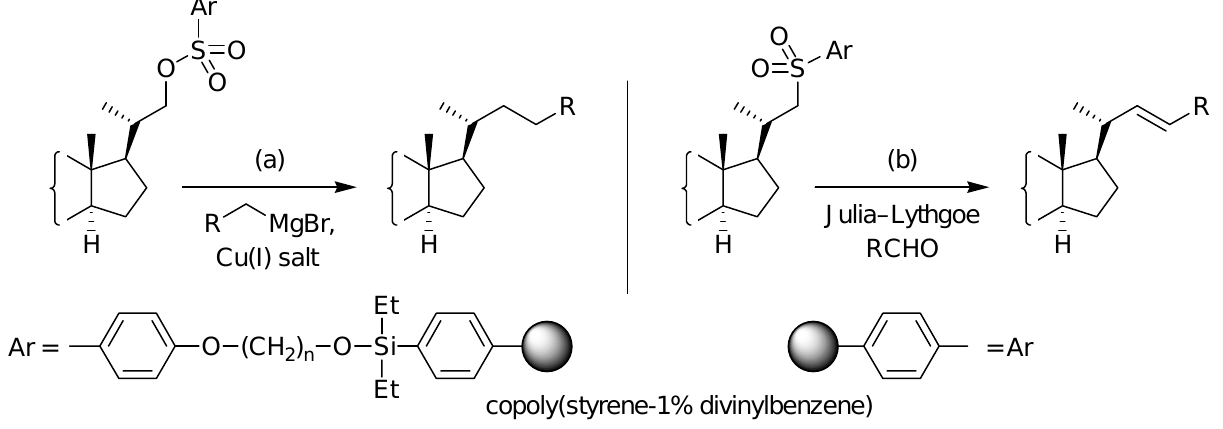
Figure 2. Side-chain construction on solid phase: (a) Takahashi's approach; (b) this